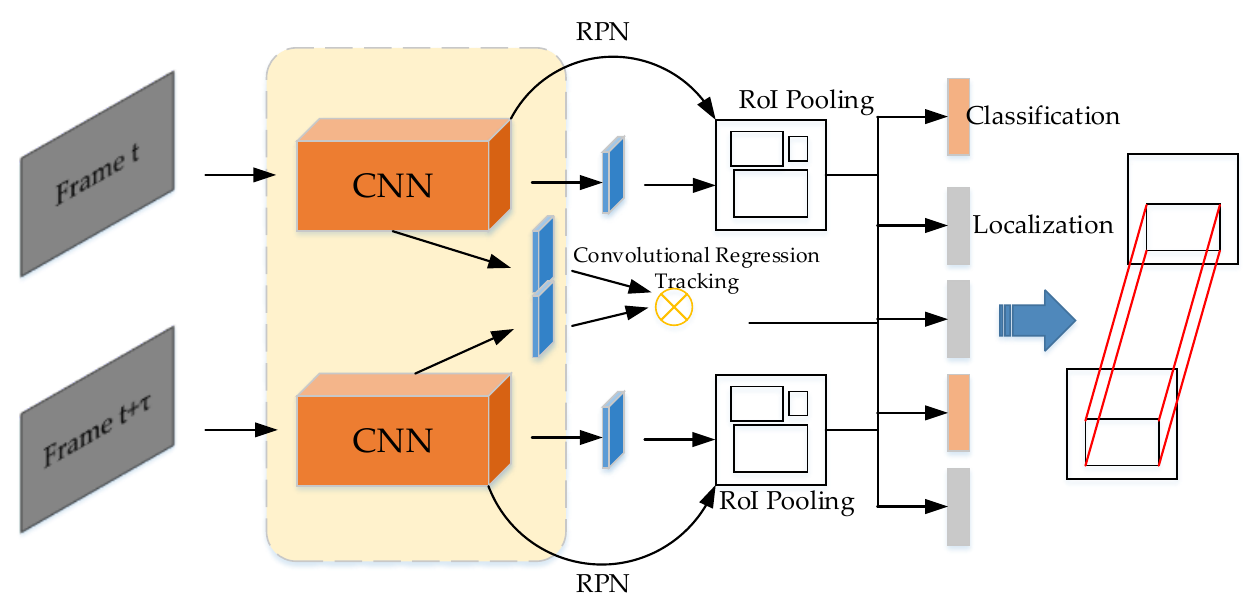
Figure 12. The structure of Convolutional Regression Tracking. Convolutional Regression Tracking is located between the 2 convolutional neural network (CNN) pipelines. The structure can improve the mAP of the image object detector, which can be used as video object detector.